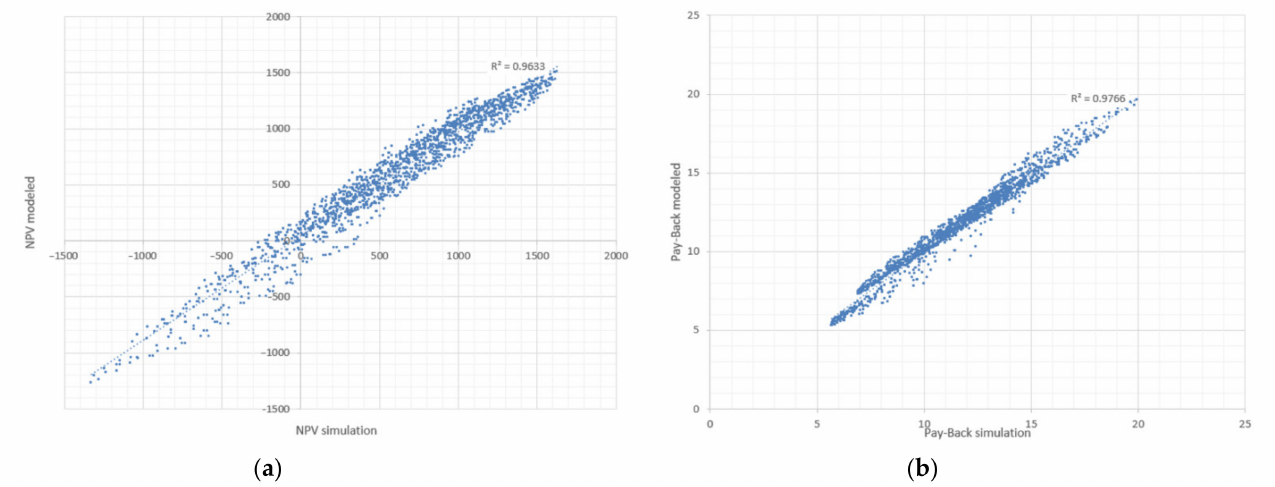
Figure 10. ( a ) Comparison of NPV obtained with the proposed model (Equation (32)) versus that obtained by simulation; ( b ) Comparison of Pay − back obtained with the proposed model (Equation (33)) versus that obtained by